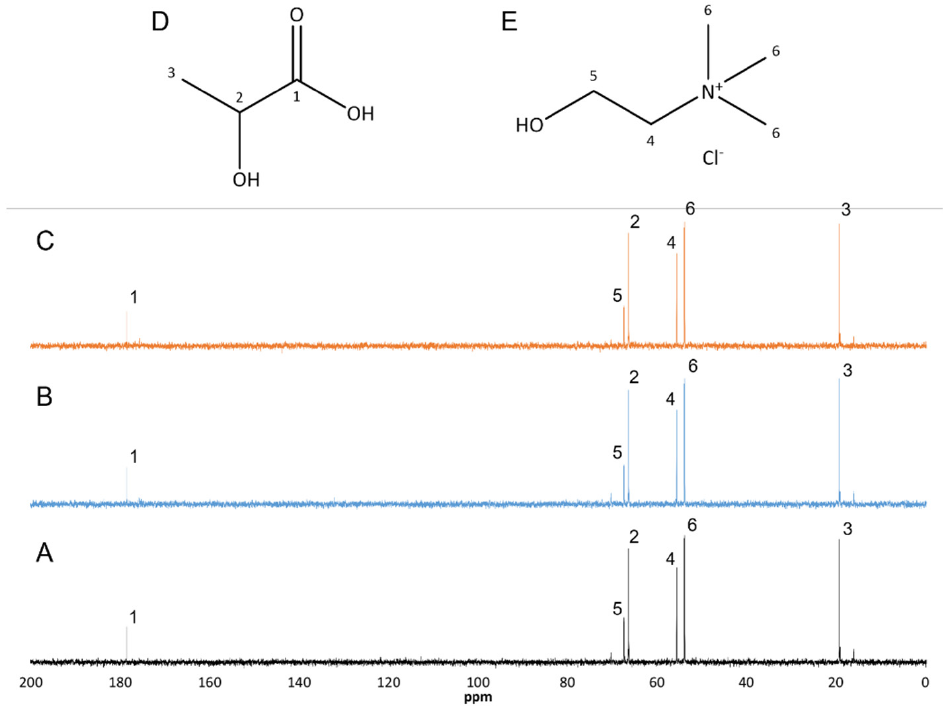
Figure 7. 13 C NMR spectra of ChCl:LacA:H 2 O (36:39:25) (m:m:m). ( A ) Control; ( B ) Incubated once; ( C ) Incubated twice; ( D ) Lactic acid molecular structure; ( E ) Choline chloride molecular structure.